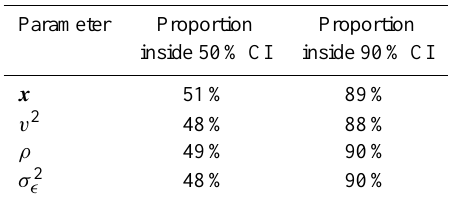
Table C1. Performance of the model fitting algorithm. All results were based on 1000 simulation